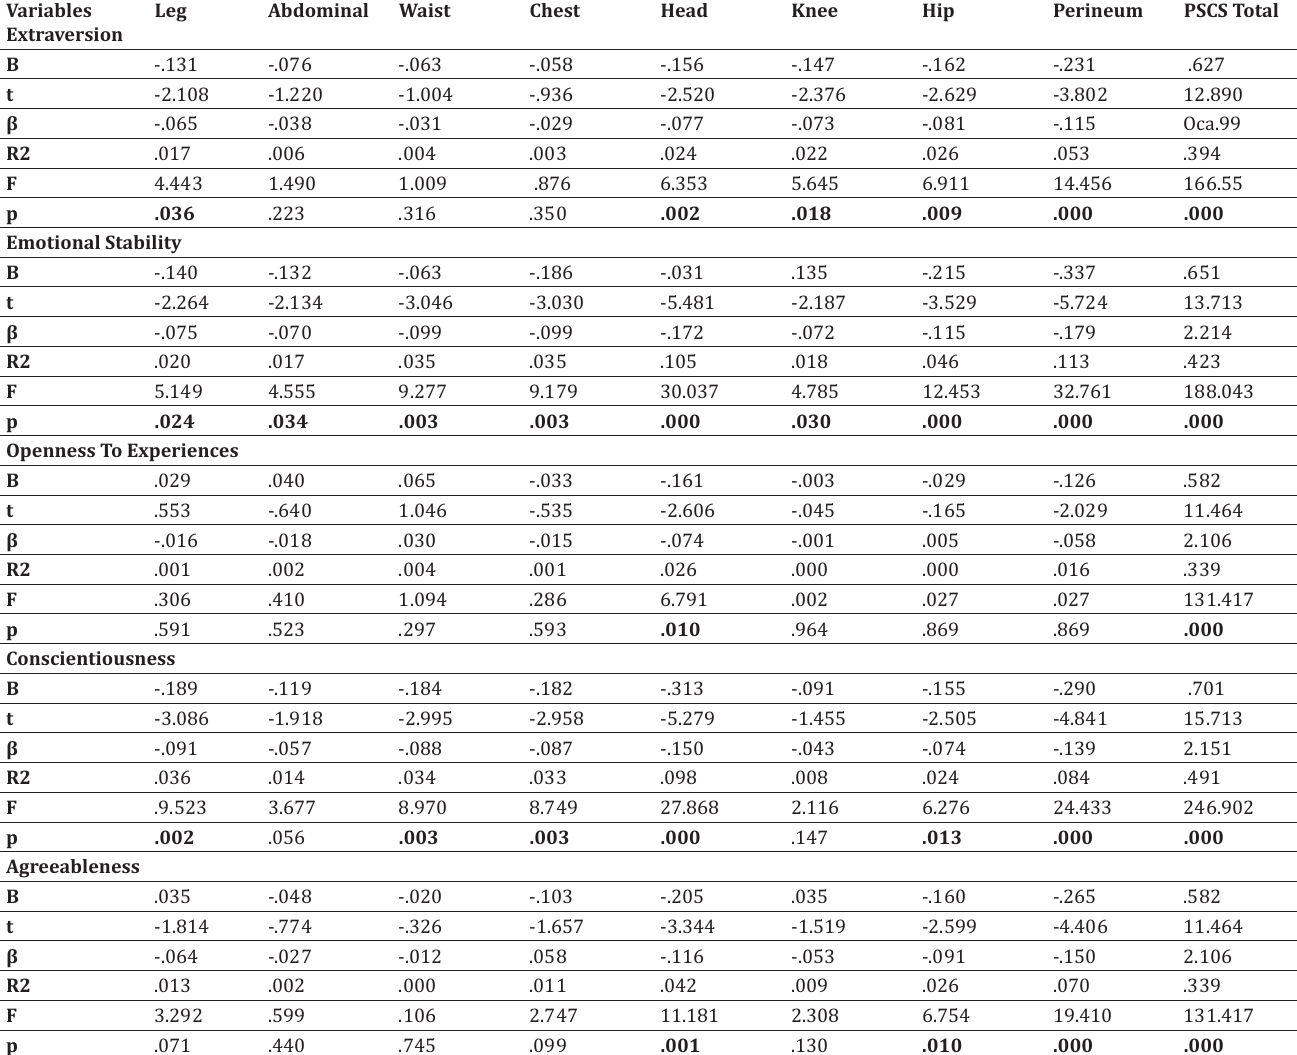
TIPI; Ten-İtem Personality İnventory, PSCS; Pharis Self-confidence Scale, r; Pearson correlation analysis, The correlation is significant at the p<0.01 level. The correlation is significant at the p<0.05 level. TIPI Multiple Linear Regression Analysis Results on the Predictions of Pain and PSCS by